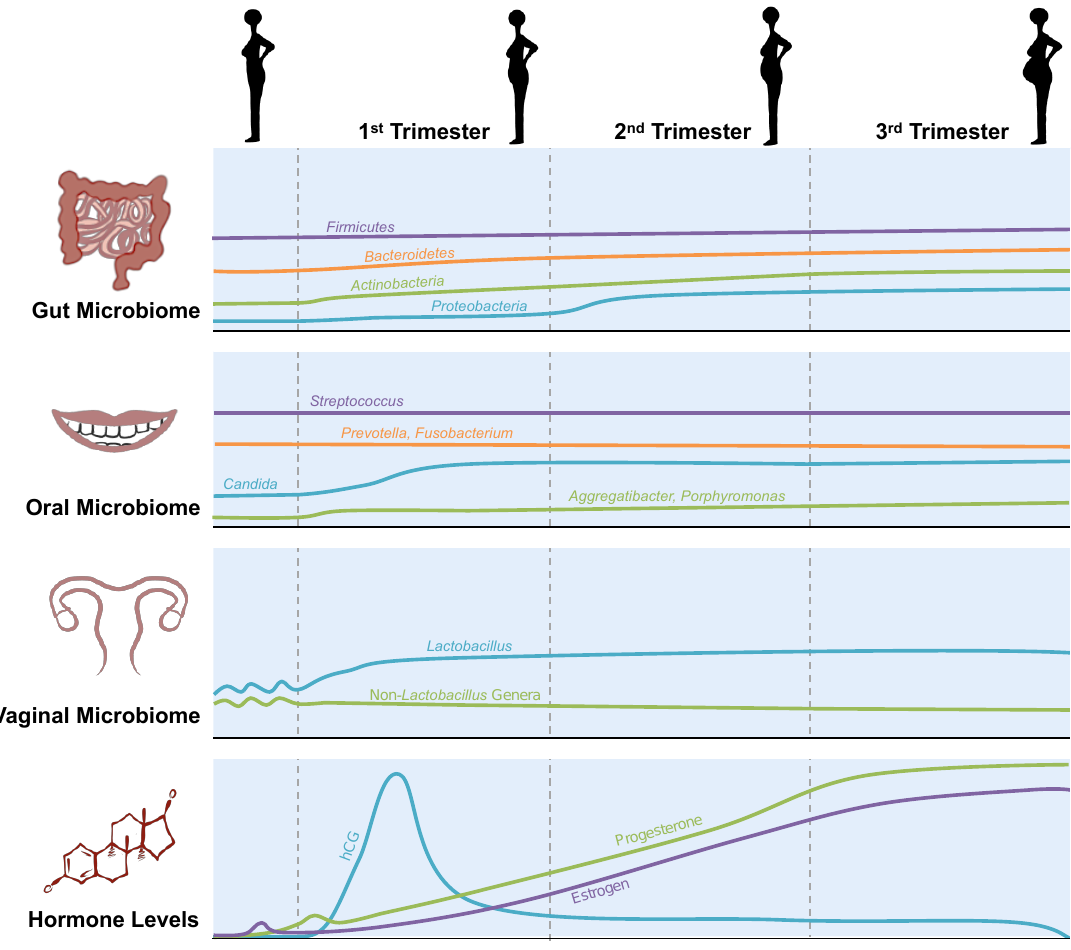
Figure 1. General changes in the gut, oral, and vaginal microbiomes in parallel with the hormonal changes throughout pregnancy. The changes that occur in the gut throughout pregnancy are complex and mediated by maternal factors, such as diet and antibiotic usage. The vaginal microbiome during pregnancy becomes more stably dominated by species of Lactobacillus , thereby decreasing in overall diversity.